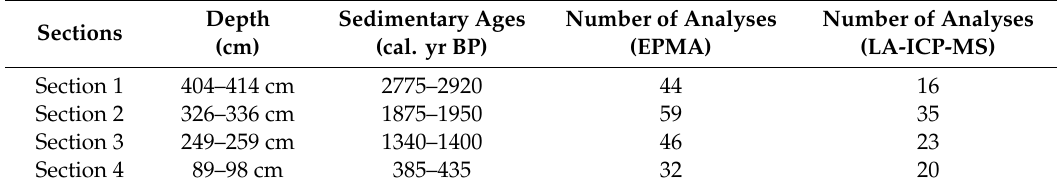
Table 1. The corresponding layers and sedimentary ages [59] and the analyzed apatite number of the four sections in Core